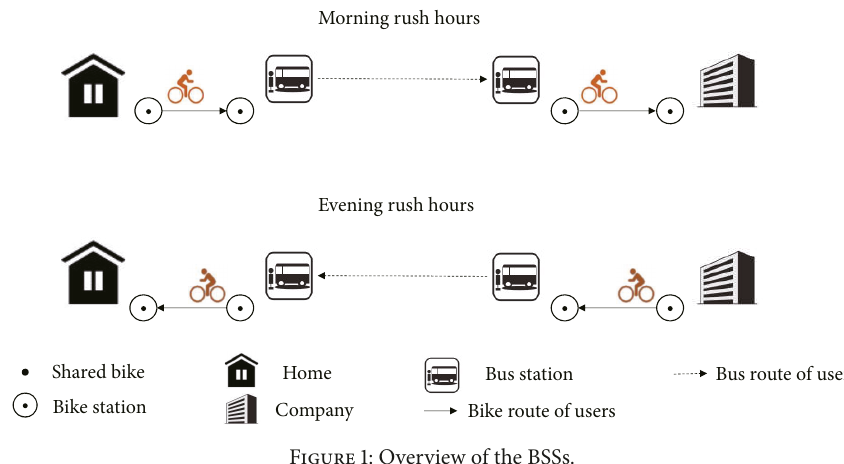
Figure 1: Overview of the BSSs.